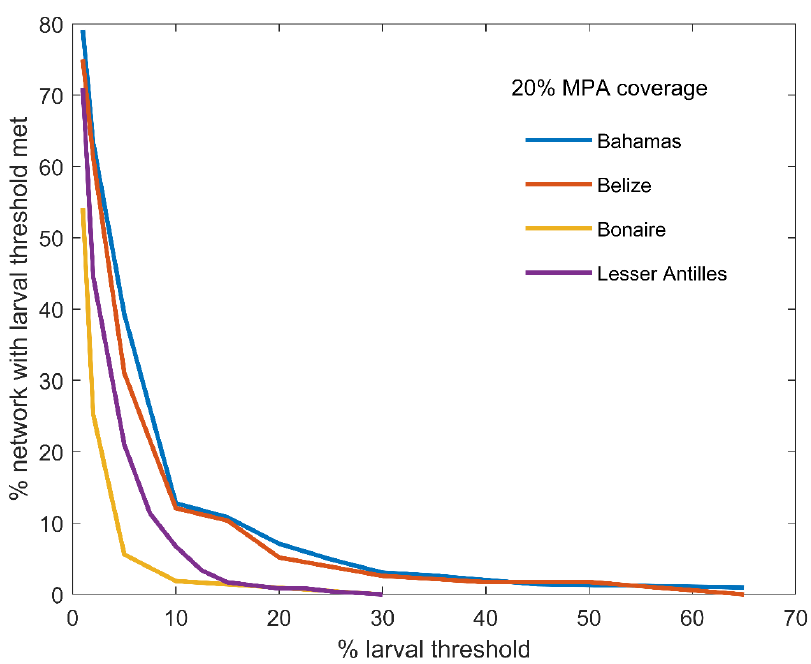
Figure 4. Proportion of sites in the global network with larval threshold met, as a function of larval threshold. The larval threshold is a predetermined value used to represent larval saturation, or the point at which larval subsidies to a site become redundant.